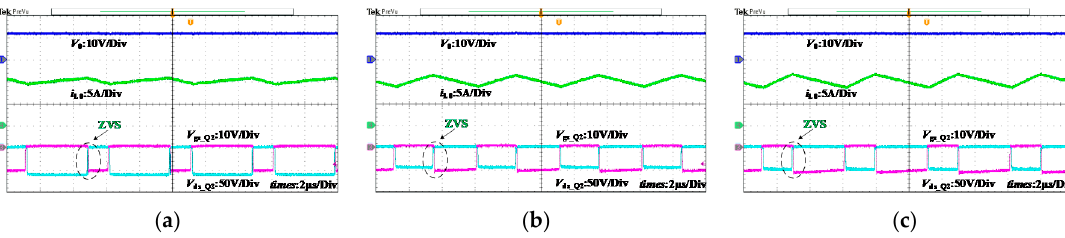
Figure 8. Measured waveforms of output voltage V 0 , inductor current i L0 , and MOSFET Q 2 under different input voltage: ( a ) V in = 18 V; ( b ) V in = 28 V; ( c ) V in = 36 V.